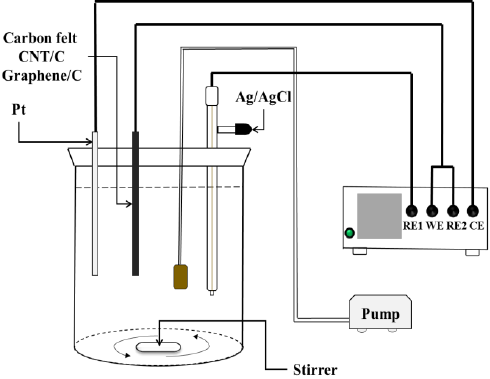
Figure 1. Schematic illustration of the electro-Fenton system.